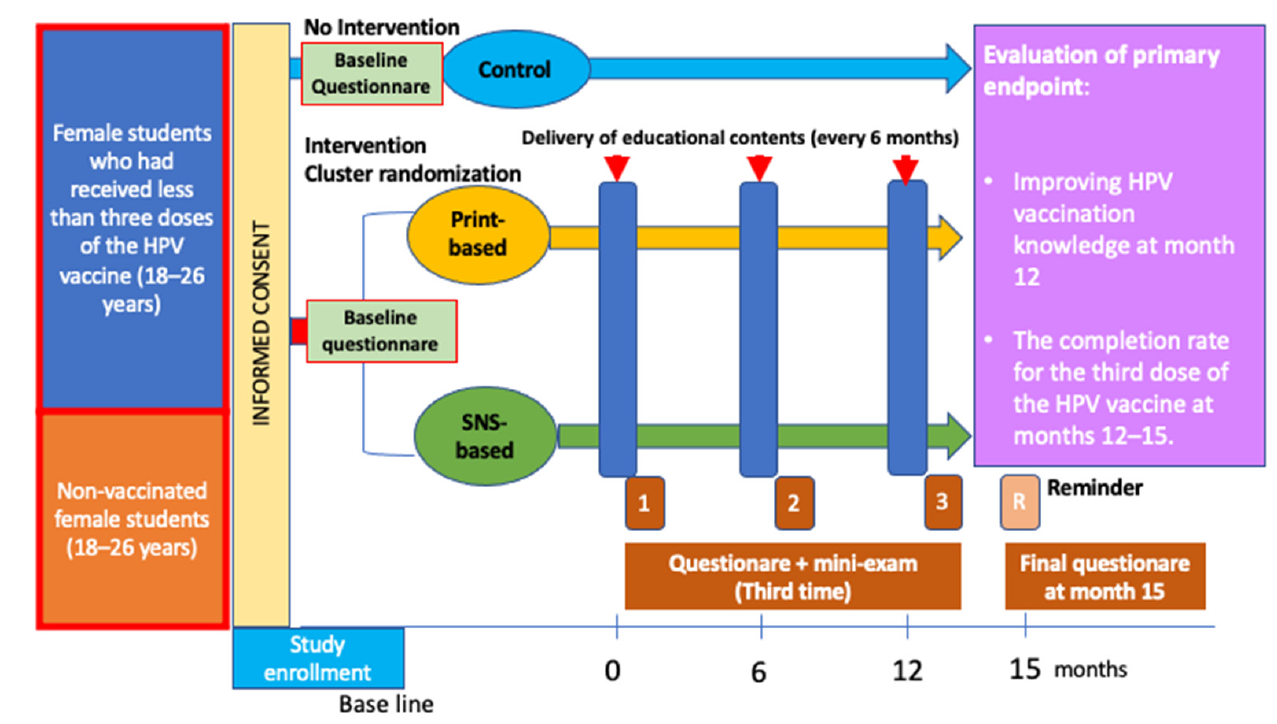
Figure 2. Study procedure.